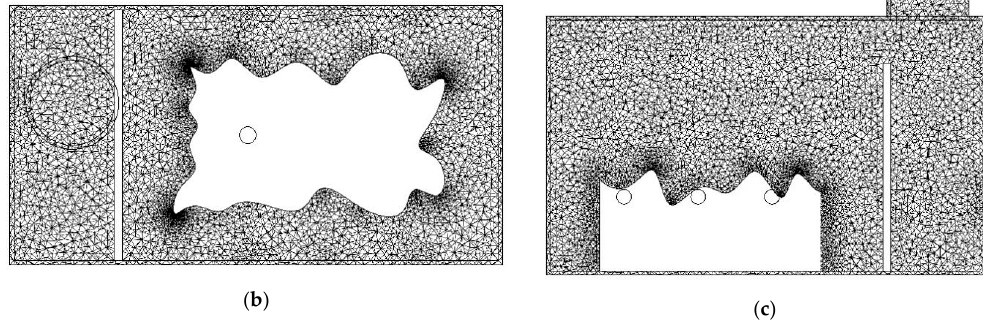
Figure 4. ( a ) The created mesh domain for the portable incinerator; ( b ) The cut plane from the above of rubbish height in (X–Z) direction to show the volume meshes; ( c ) The cut plane in (X–Y) direction to show the involved volume meshes in the computational domain.